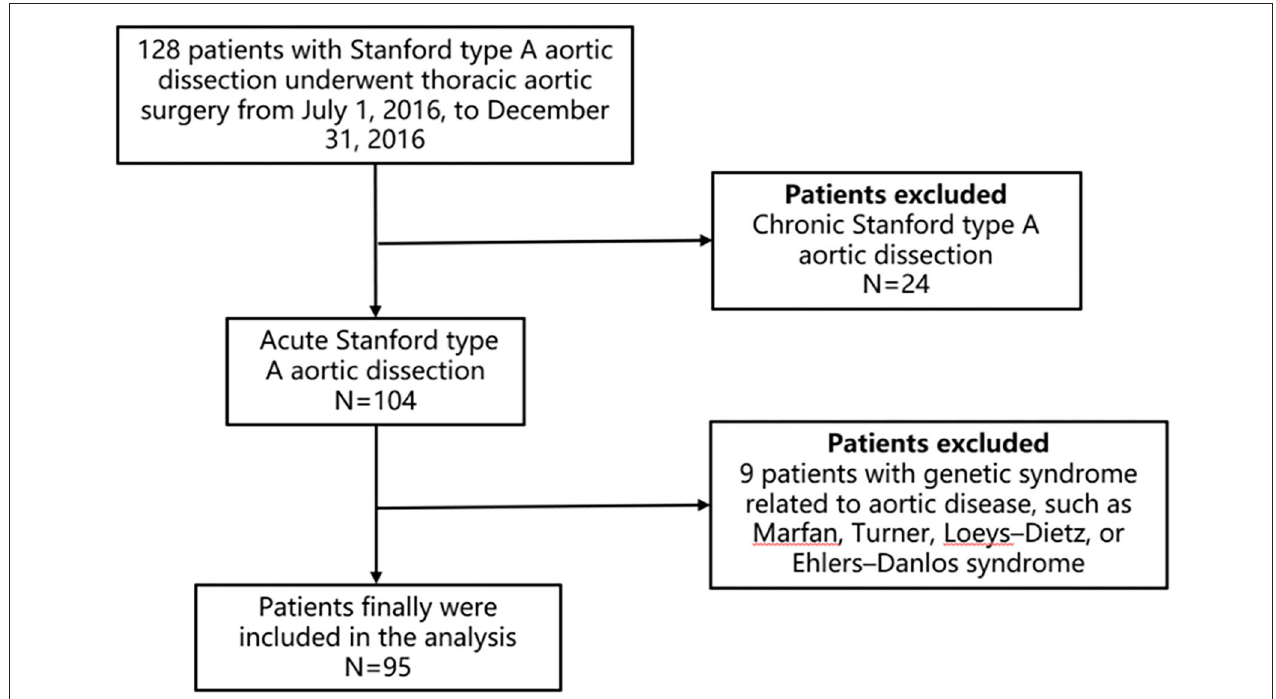
FIGURE 1 | Flowchart of the screening and enrollment of study patients.